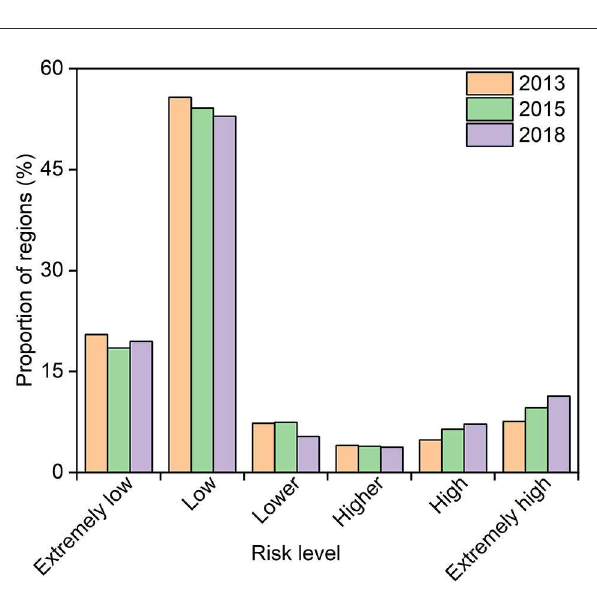
FIGURE6 Proportion of regions with different O 3 exposure risk levels to the total land area